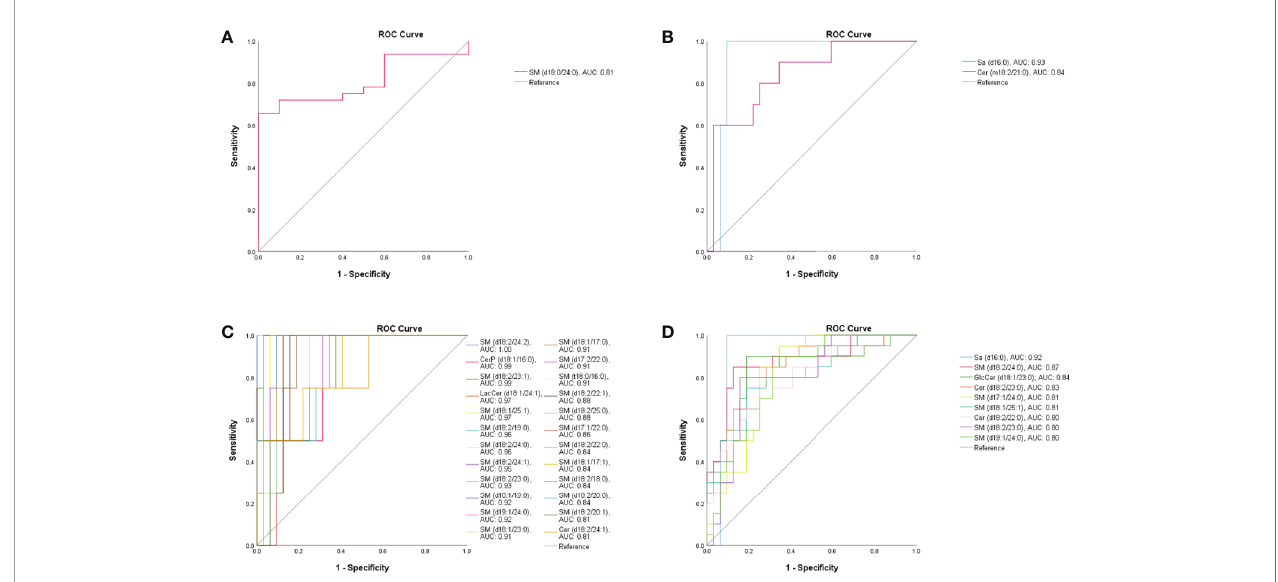
FIGURE 4 | The ROC curve for SPLs with an AUC value > 0.80. (A) One SPL displayed a higher level and (B) 2 SPLs displayed lower levels in patients with T marneffei infection (TM group) than in patients with bacterial pneumonia. (C) Twenty-four SPLs capable of differentiating TM subjects from patients with viral pneumonia. (D) Nine SPLs that could distinguish TM subjects from patients with pulmonary